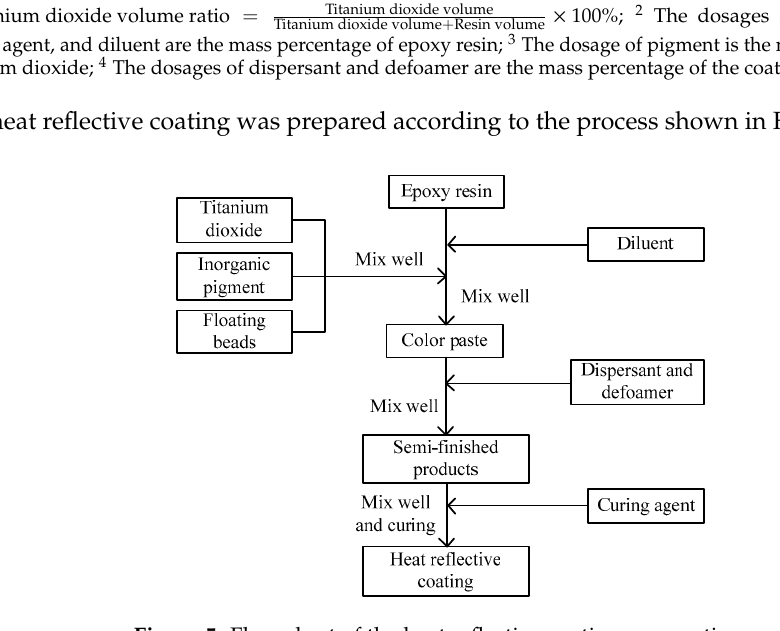
Figure 5. Flow chart of the heat reflective coating preparation.